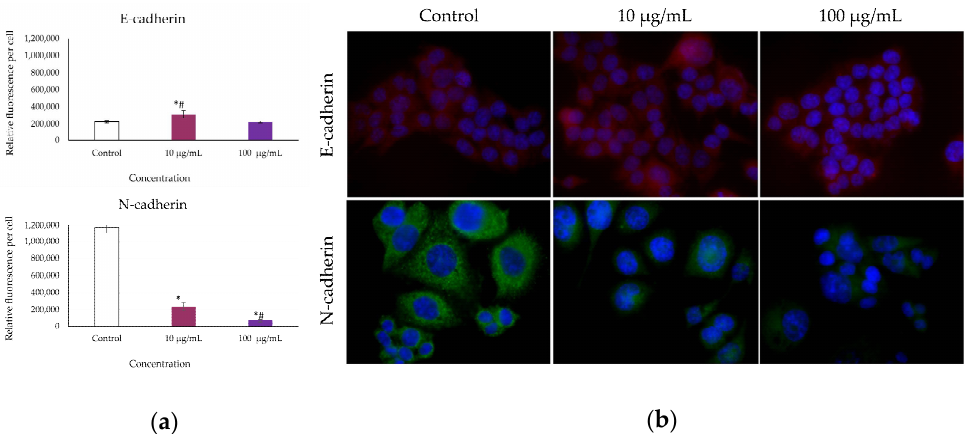
Figure 2. Protein expression of E-cadherin and N-cadherin in HCT-116 cells 24 h after treatment with RJ. Results expressed as relative fluorescence per cell (means ± SE; * p > 0.005 statistically significant difference compared to control, # p > 0.005 statistically significant difference between treatment concentrations ( a ). Representative micrographs showing fluorescently labeled target proteins; cell nuclei are stained blue; E-cadherin is stained red; N-cadherin is stained green ( b ).